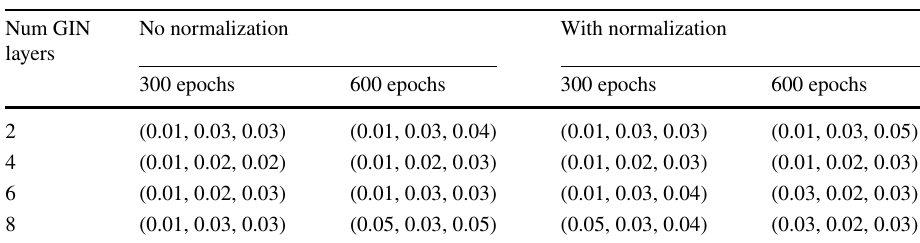
Table 1 Experimental results for polarization computation with our 1GNN model